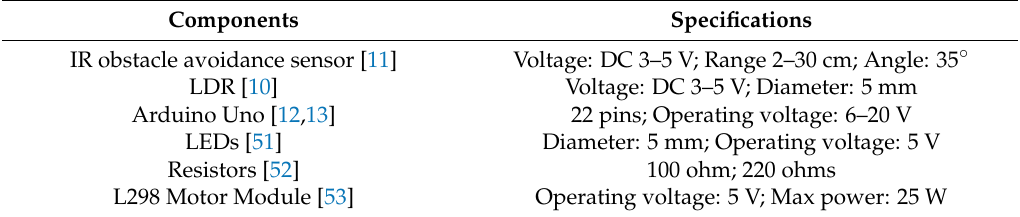
Table 1. Specification of electronic components used in to design the proposed system.